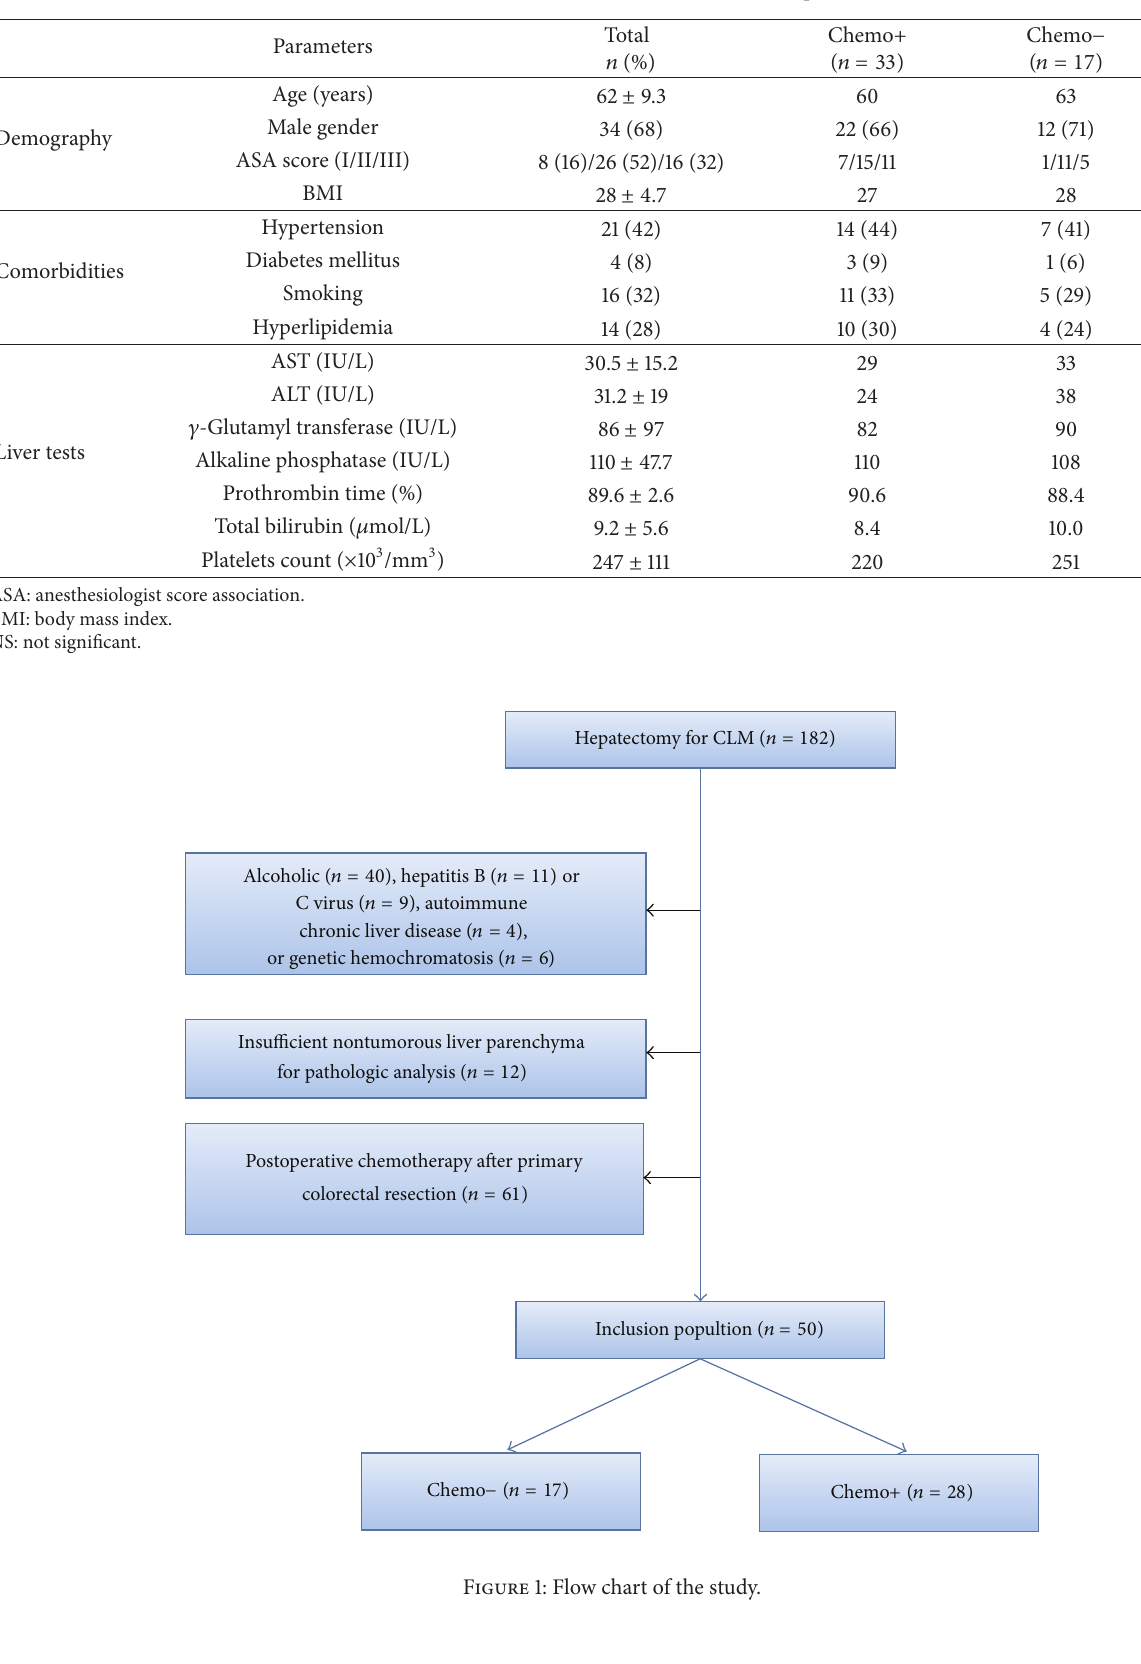
Table 1: Baseline characteristics of the 50 included patients.